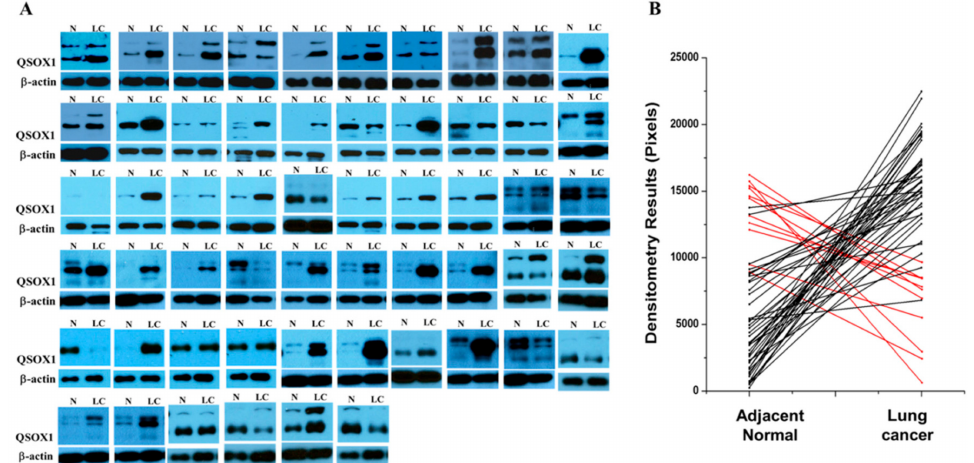
Figure 2. QSOX1 proteins present at higher levels in lung cancer tissues compared to corresponding adjacent normal tissues. ( A ) Proteins extracted from lung cancer tissues and their corresponding tissues from 56 lung cancer patients. For each sample, 2.5 µ g of proteins were subjected to Western blot analysis. QSOX1 was detected as two forms, long (74 kDa) and short secreted forms (65 kDa). ( B ) Graphs of densitometry analysis data showed 48 out of 56 patients (about 85.7%) had an increase in QSOX1 protein expression in lung cancer tissue, compared to adjacent normal tissue. N: normal, LC: lung